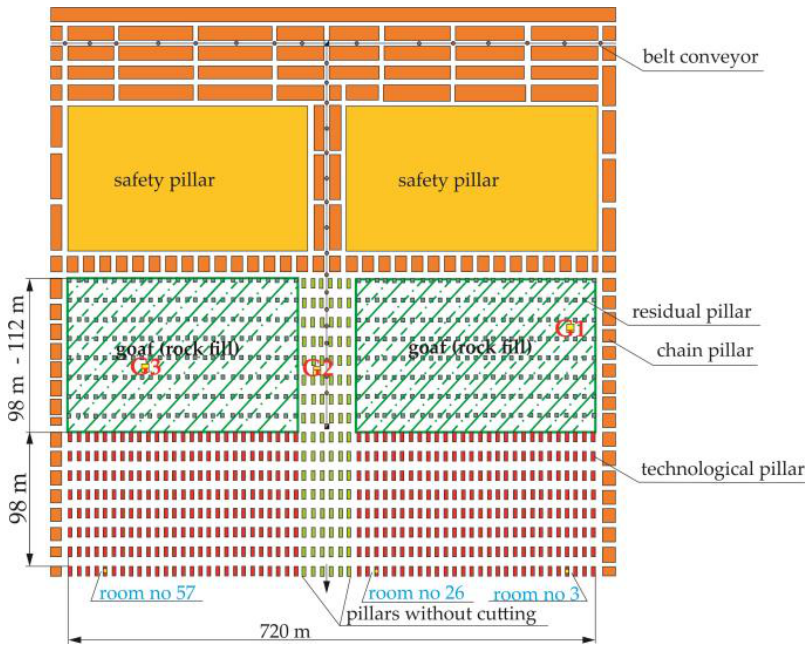
Figure 10 . Room and pillar method with roof deflection and maintaining the central part of the mining field.